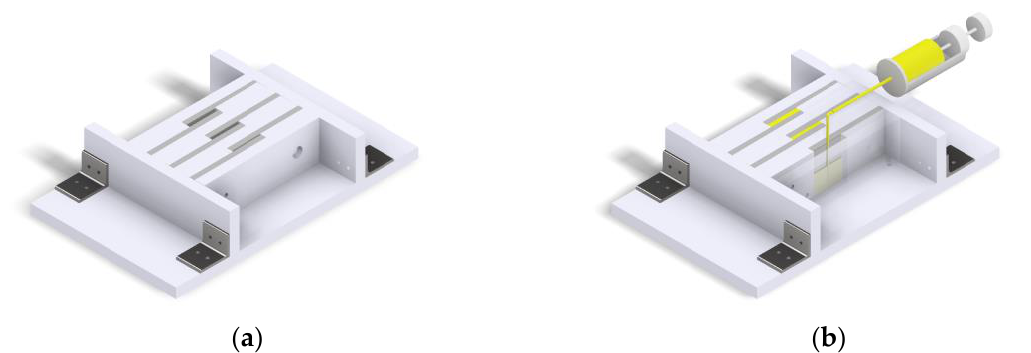
Figure 2. Adhesive bonding of the overlap joint in accordance with [22]. ( a ) Placing the blasted and degreased substrates into the production device. ( b ) Adhesive application by injection on the bottom of the joint gap until the adhesive emerges at the top of the joint gap.